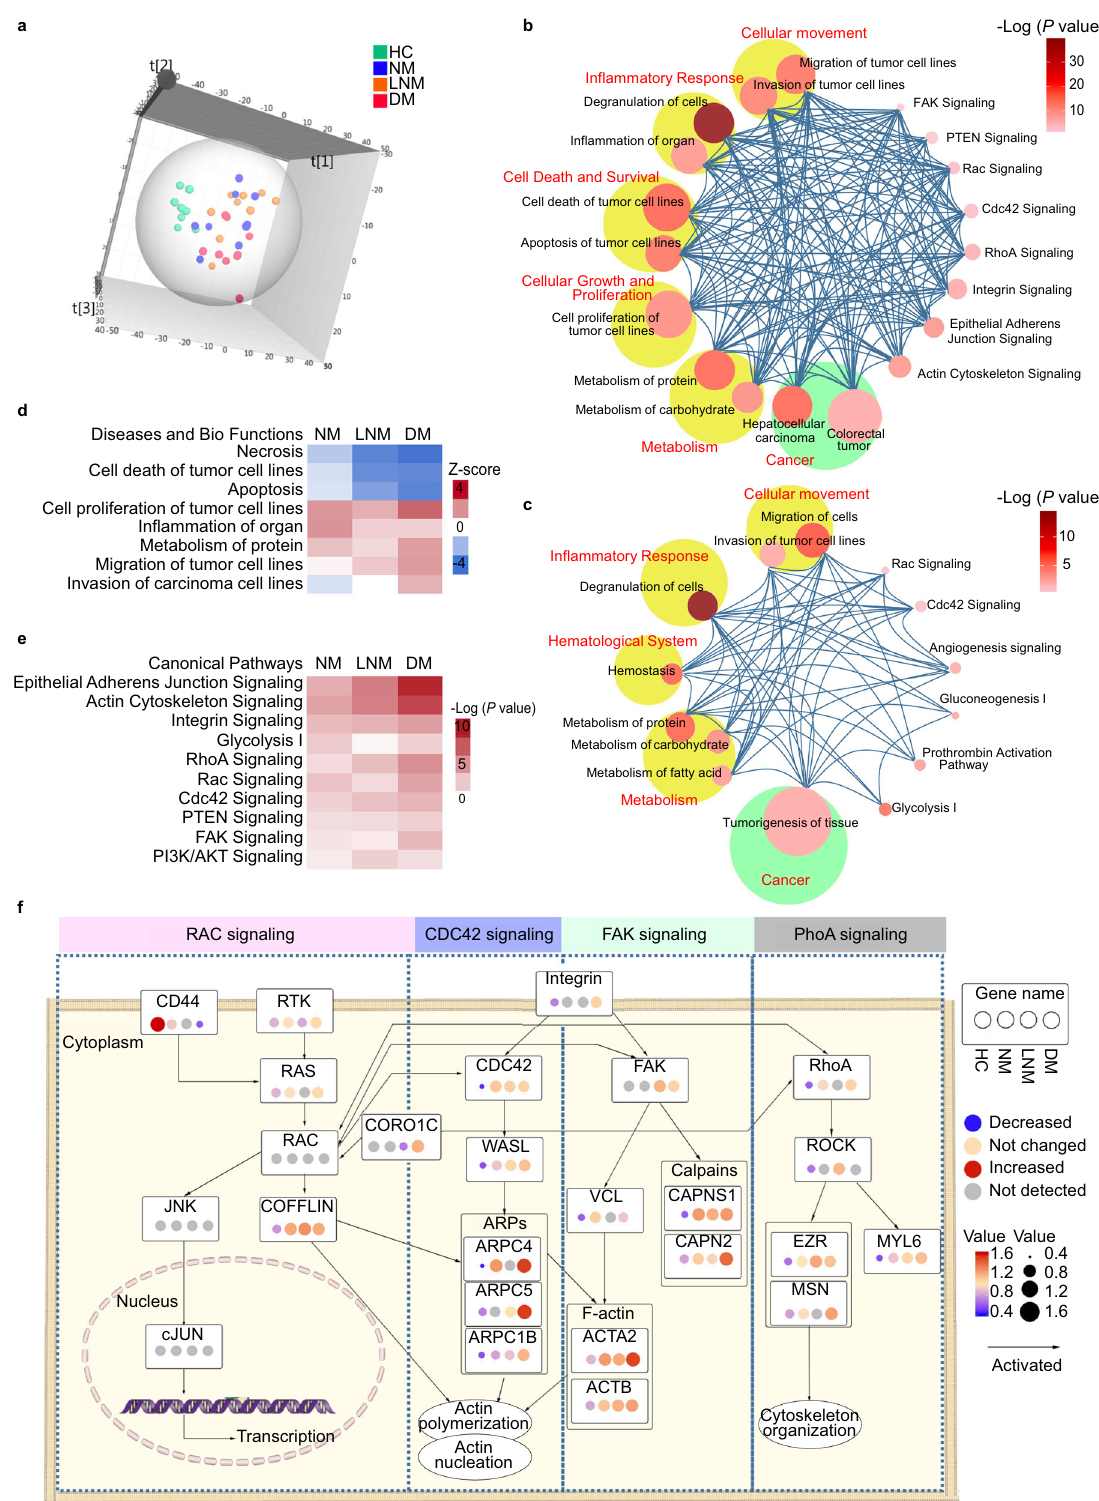
with sensitivity, speci fi city, accuracy, and AUCs of 69.2%, 70.0%, 69.7%, and 0.723 as well as 83.3%, 75.0%, 79.6%, and 0.827, respectively (Supplementary Table 2 and Supplementary Fig. 2c).